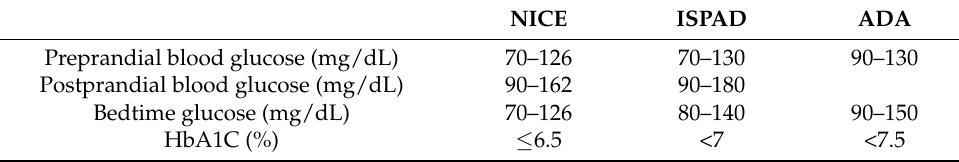
Table 1. Reference values for blood glucose and HbA1c according to different societies. NICE ISPAD ADA Preprandial blood glucose (mg/dL)